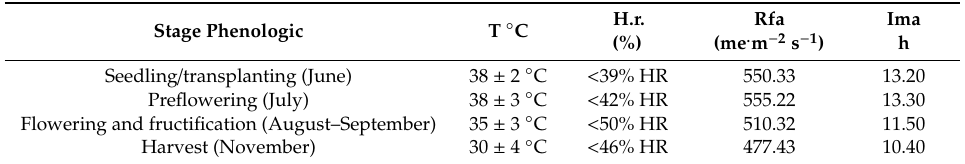
Table 2. Environmental conditions (T ◦ C, Hr, photosynthetically active radiation (Rfa: me . m − 2 s − 1 ) and average annual insolation (Ima h . day)) present in the di ff erent phenological stages of tomato production (saladette variedad TOP 2299) treated by the e ff ect of Azospirillum brasilense (Ab) as a PGPB and manure on the shadow house